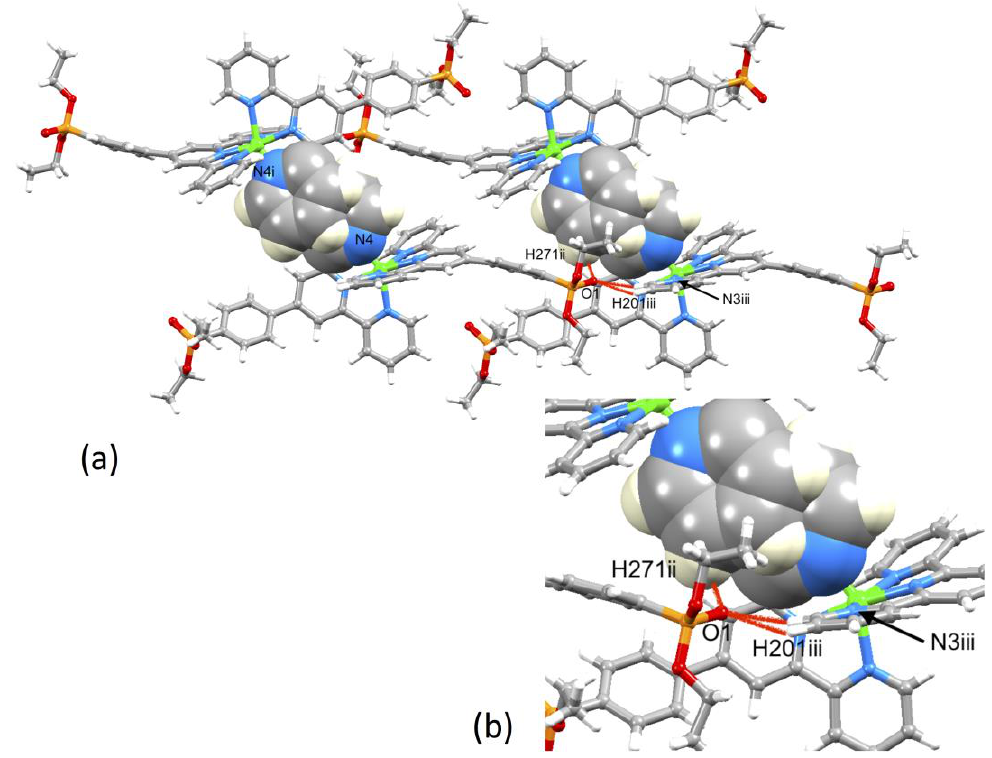
Figure 7. ( a ) Intercation packing interactions between [Zn( 2 ) 2 ] 2+ cations in [Zn( 2 ) 2 ][CF 3 SO 3 ] 2 and ( b ) expansion of the close P – O...H – C contacts. Anions are omitted. Symmetry codes: i = − x , 1 − y , 1 − z ; ii = − x , − y , 1 − z ; iii = x , − 1+ y , + z .